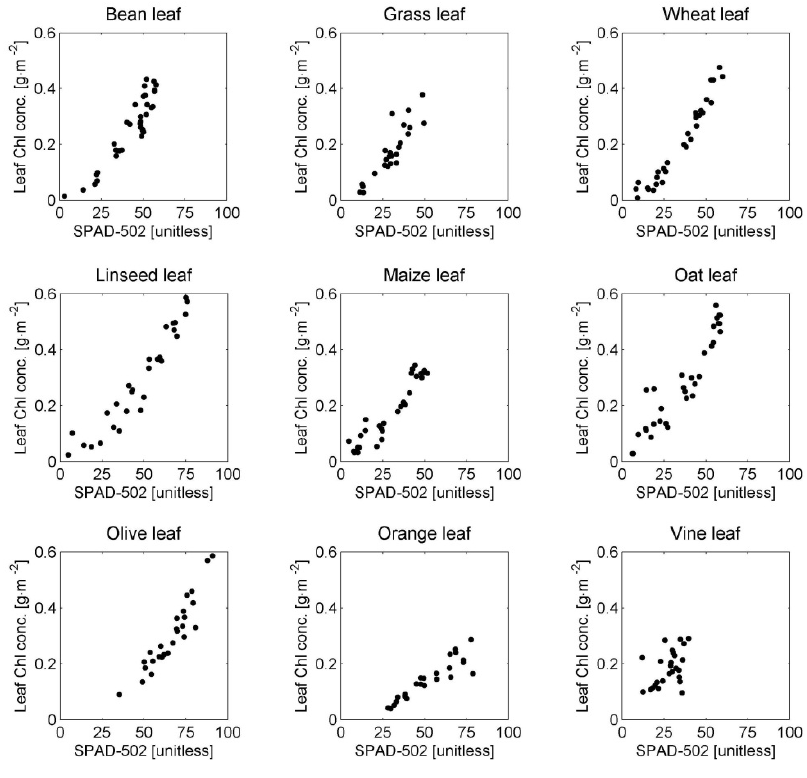
Figure 1. An overview of the scatter around relationships between SPAD-502 readings and leaf chlorophyll concentration extracted in the laboratory for nine leaf types. This dataset is part of our past experimental campaigns and destructive chlorophyll extraction was performed according to the procedures described in